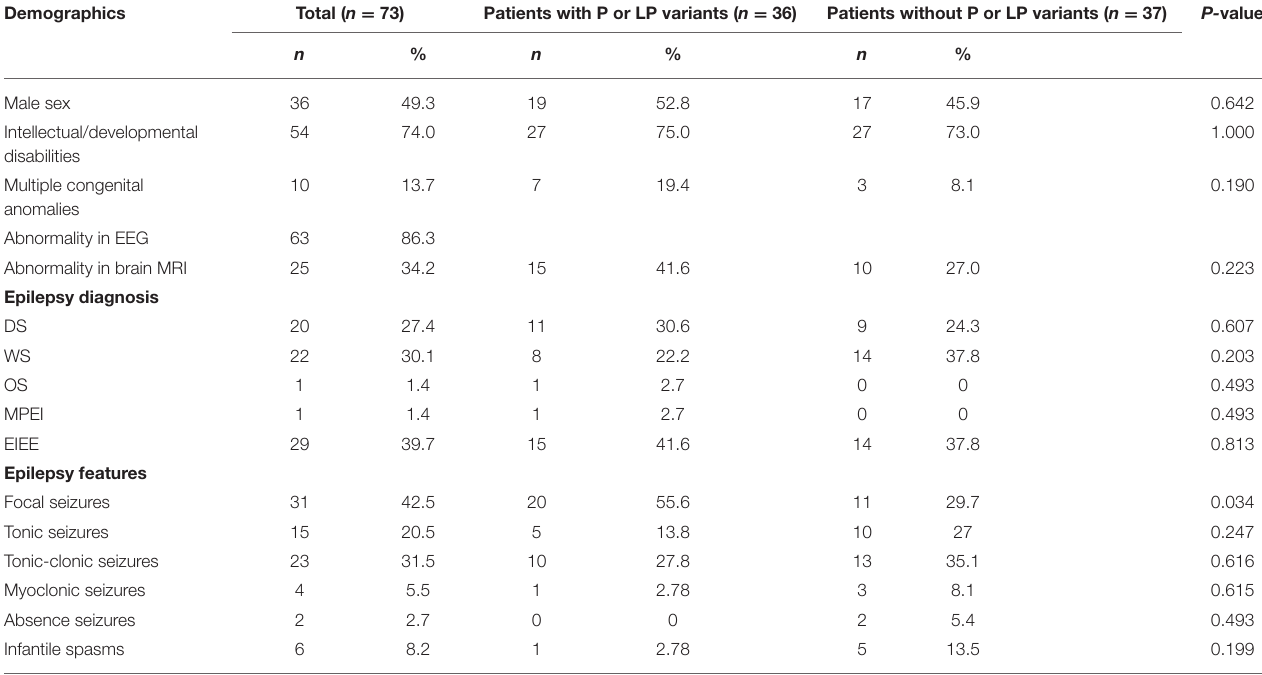
TABLE 1 | Demographic and baseline clinical characteristics of the patients with EEs. Demographics Total ( n = 73) Patients with P or LP variants ( n = 36) Patients without P or LP variants ( n = 37) P-